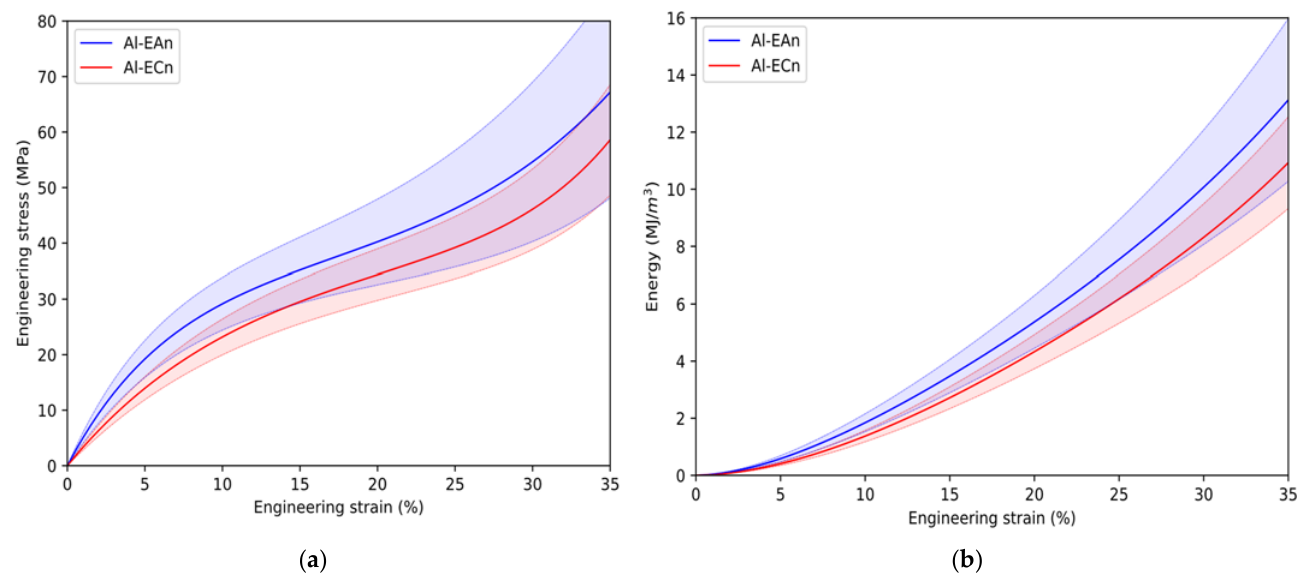
Figure 7. Average mechanical behavior of each series: ( a ) stress–strain curve and ( b ) energy absorp- tion capacity.